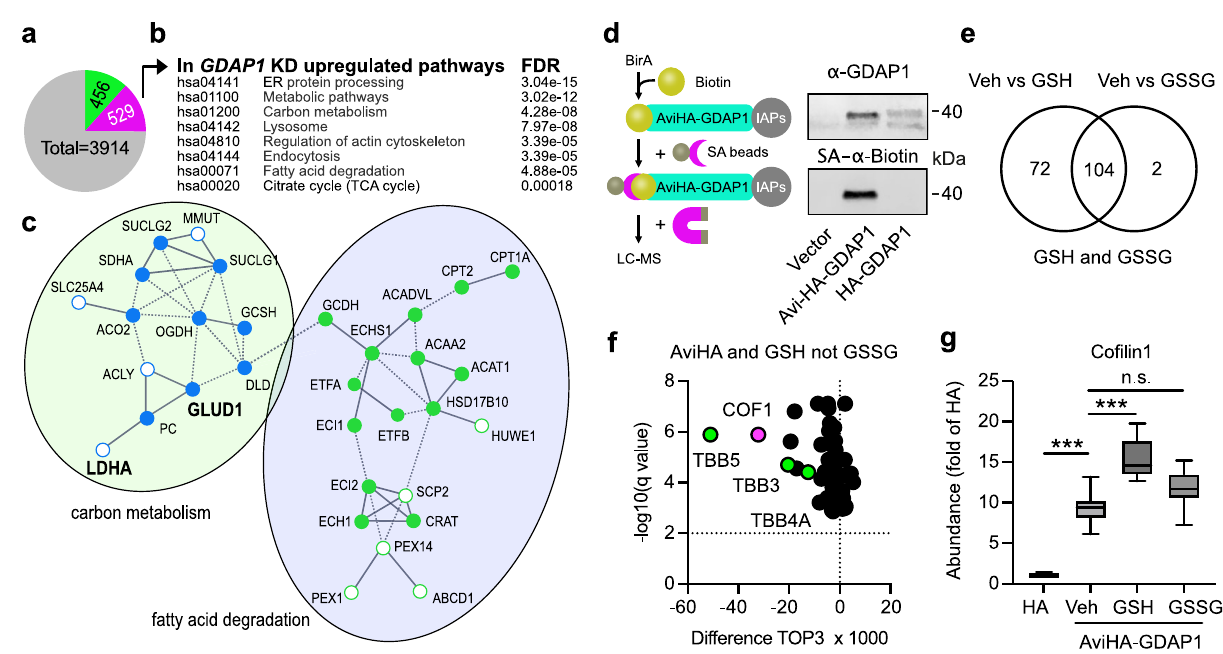
Fig. 6 LC-MS proteomics identi fi es proteins involved in β -oxidation as being more abundant in GDAP1 KD cells and hints to alterations of the actin cytoskeleton mediated by redox-dependent interactions with GDAP1. a Number of proteins dysregulated in GDAP1 KD cells identi fi ed by label-free proteomics from three independent experiments, measured in quadruplicates, green less abundant, magenta more abundant. Statistical signi fi cance was determined by Student ’ s t test with Bonferroni correction. b KEGG pathways signi fi cantly altered in proteins more abundant in GDAP1 KD cells. c Section of a STRING analysis of proteins more abundant in GDAP1 KD cells corroborating altered carbon metabolism (blue) and fatty acid degradation (green) in these cells. Open dots correspond to more abundant interacting proteins that do not fall directly into these categories. Proteins in bold were found to be more abundant independently using immunoblotting. d Schematic illustration showing the biotinylation of the AviTag fused to GDAP1 protein and subsequent pulldown and enrichment of biotinylated GDAP1 protein via streptavidin-labeled magnetic beads. Immunoblot of cell lysates prior to pulldown of biotinylated GDAP1 stained against GDAP1 and Biotin with an infrared-labeled streptavidin (SA) dye shows an overlap of biotinylation and GDAP1 protein. Streptavidin pulldown was performed with primary neuronal cultures from BirA-expressing E16 mouse embryos. e Results from label-free quantitative proteomics performed with GSH or GSSG added to the preparation, ( f ) shows the 72 proteins with an altered expression after addition of GSH but not GSSG. g TOP3 quanti fi cation of Co fi lin-1 abundance and increased Co fi lin-1 abundance upon GSH, but not GSSG addition indicated an interaction with GDAP1 in a redox-dependent manner. Statistical signi fi cance in g was determined by one-way ANOVA and the Tukey test, *** p < (Fig. 6b). The analysis corroborated the increased levels of LDHA and GLUD1 observed by immunoblotting (Fig. 2c). It also demonstrated increased levels of proteins involved in β -oxidation (Fig. 6c) like carnitine palmitoyltransferase 1 (CPT1A) which catalyzes the transfer of the acyl group of long-chain fatty acid- CoA conjugates onto carnitine to transport the resulting acyl- carnitine long-chain fatty acids inside the mitochondria. These results suggest that the decrease in lipid droplets observed in GDAP1 KD cells (Fig. 2f) indeed re fl ects a high lipid catabolism that serves to provide the TCA cycle with acetyl-CoA.